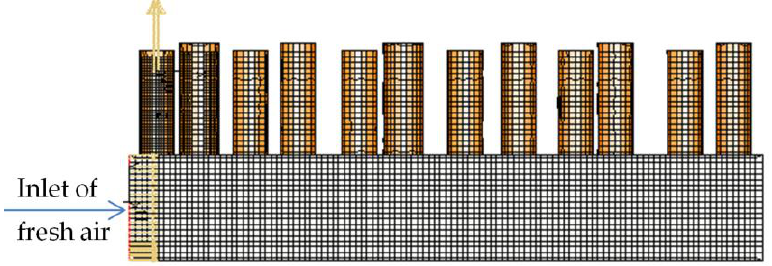
Figure 2. Simulation model.